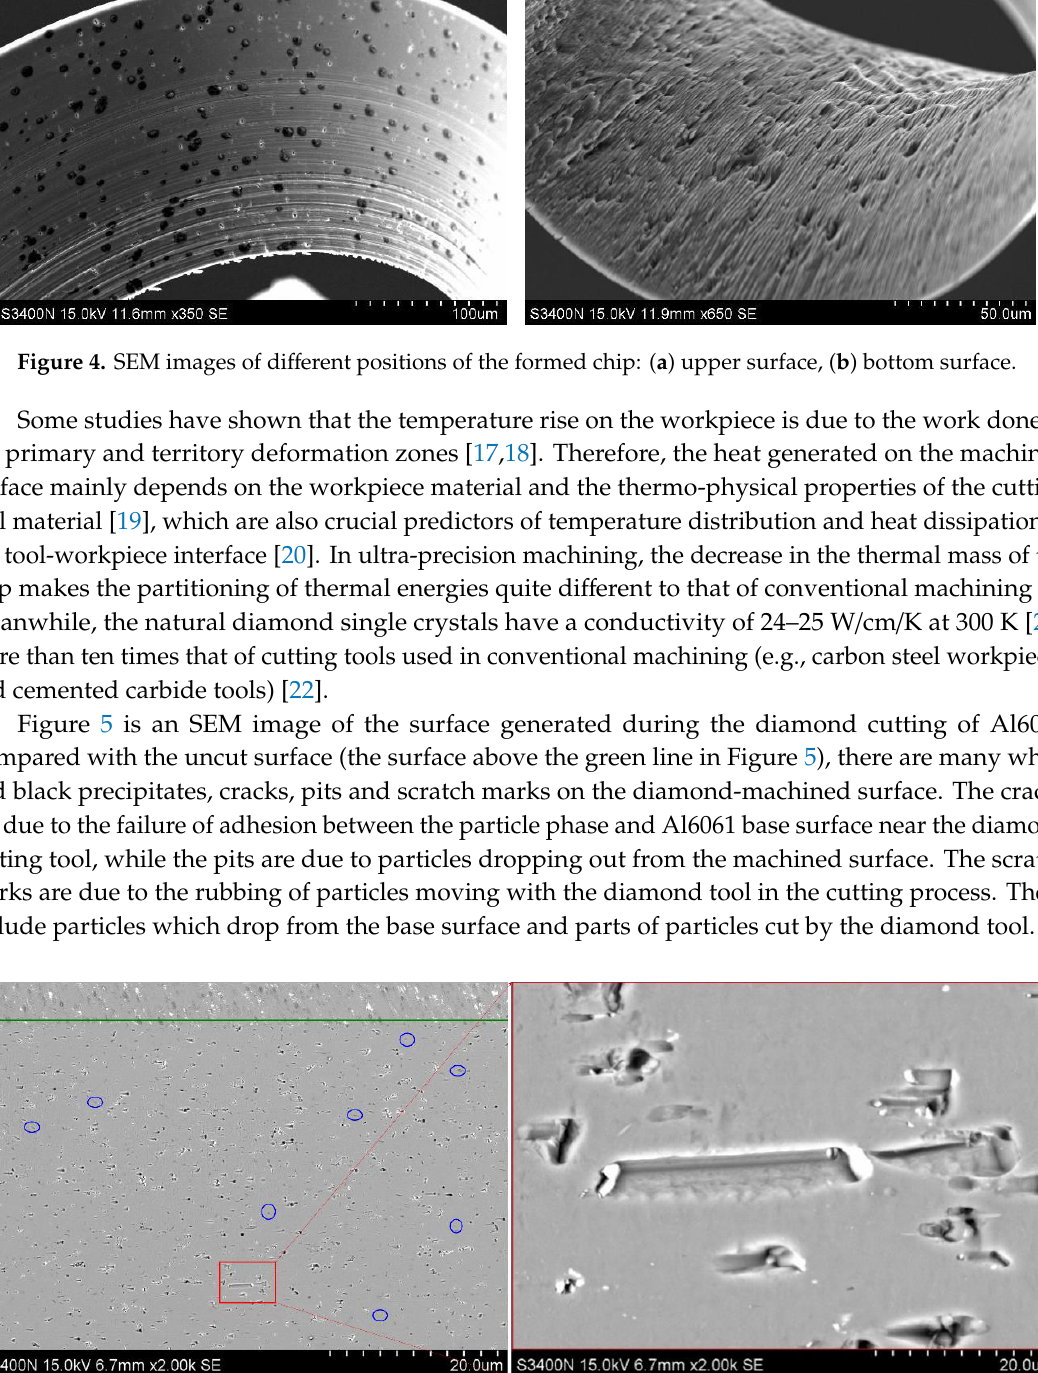
Figure 5. SEM images of the freshly generated surface of Al6061.